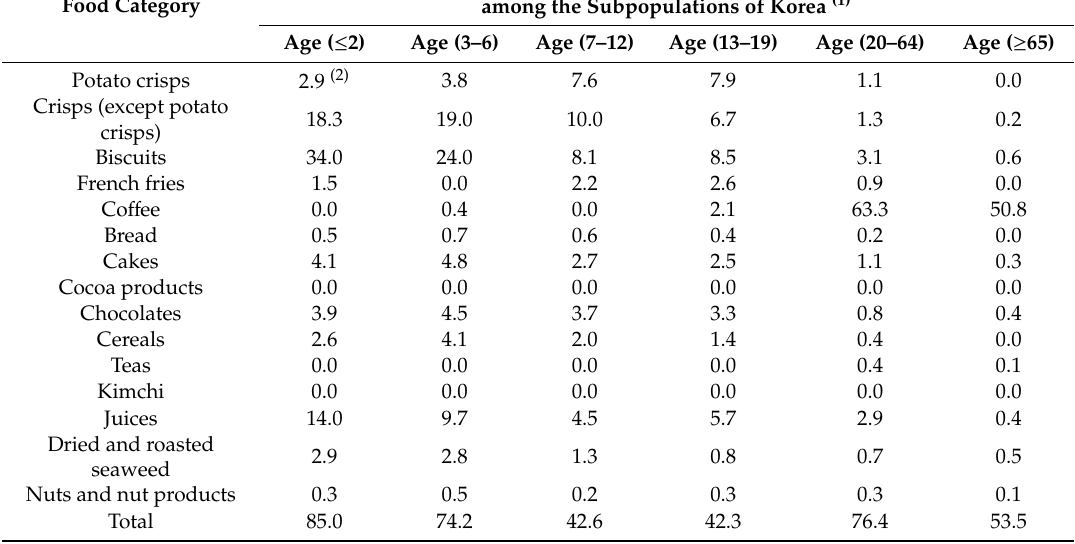
Table 3. Dietary exposure to acrylamide among the subpopulations of Korean based on the median values of dietary